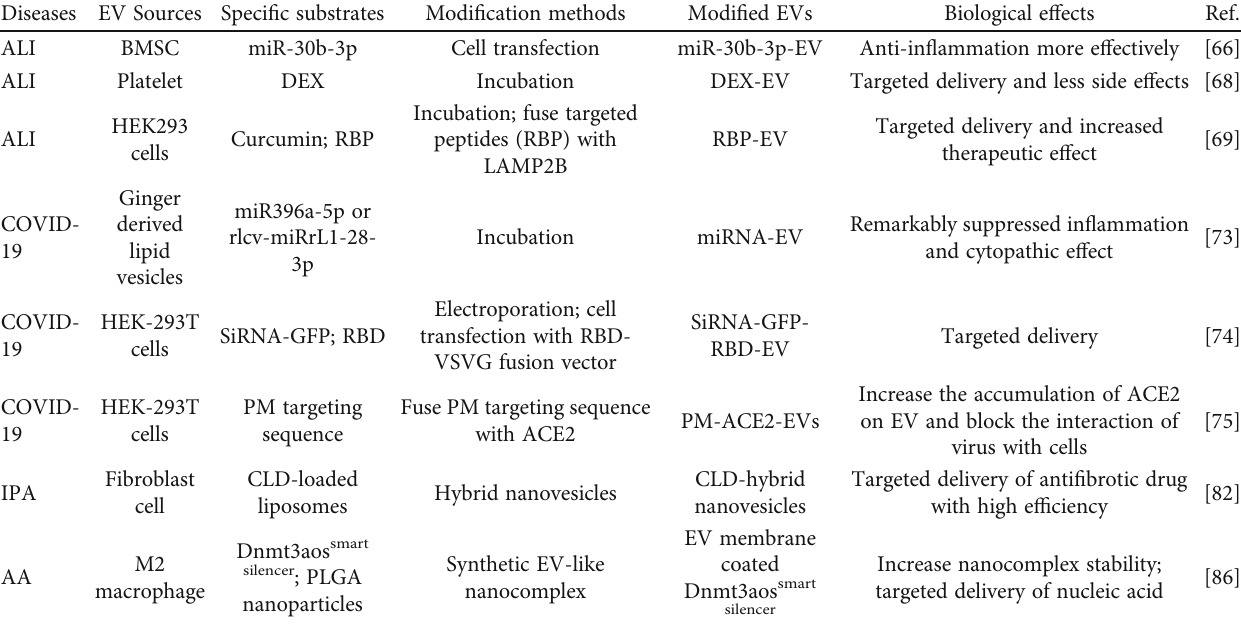
Table 3: Modi fi ed EVs in the therapy of lung